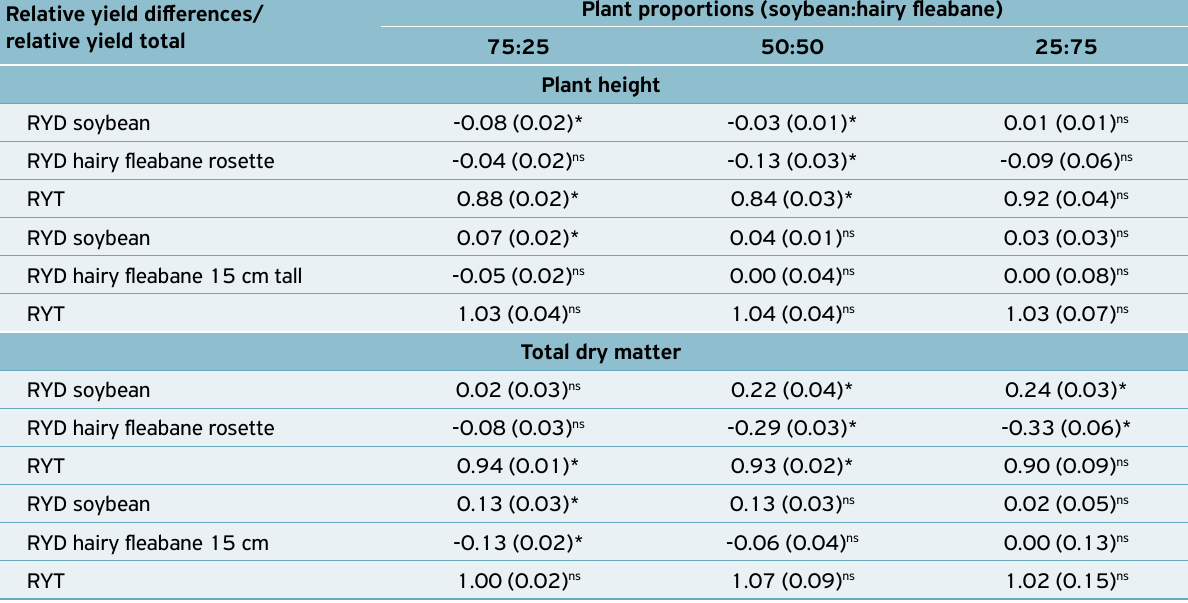
ns Not significant; *significant by the t test (p ≤ 0.05). Values in parentheses are the standard errors of the